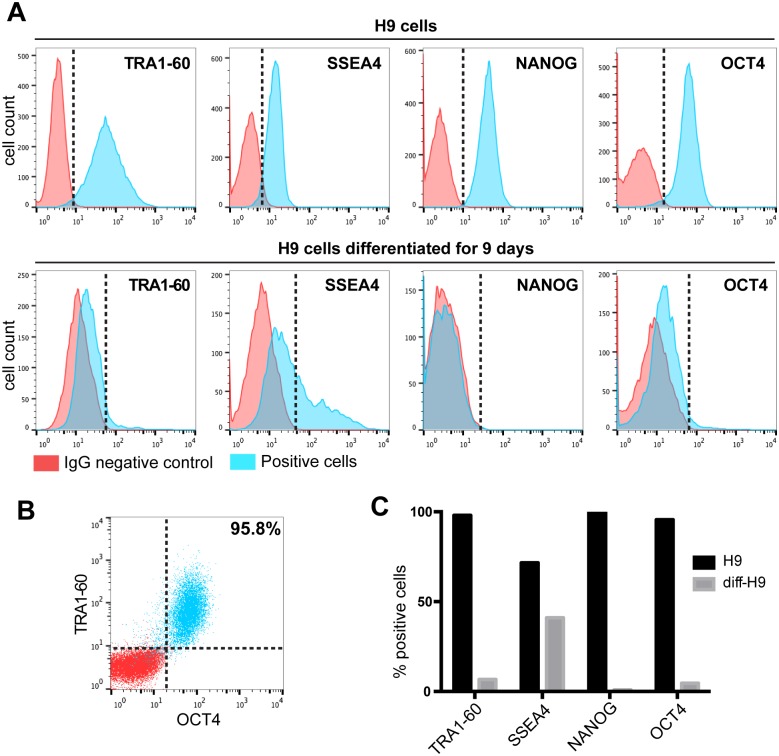
Simultaneous detection of four pluripotency markers by flow cytometry.(A) Flow cytometric analysis of permeablized H9 hESCs. Cells were exposed to antibodies against TRA1-60, SSEA4, NANOG and OCT4. IgG antibody was used as negative control. Top: Cytometry profiles of undifferentiated H9 cells. Bottom: Cytometry histograms of H9 cells 9 days after removal of bFGF. (B) Flow cytometric analysis of undifferentiated H9 cells for the co-stained for TRA1-60 and OCT4. (C) Quantification of positive cells for TRA1-60, SSEA4, NANOG and OCT4 in comparison to IgG control for both undifferentiated and differentiated H9 cells.